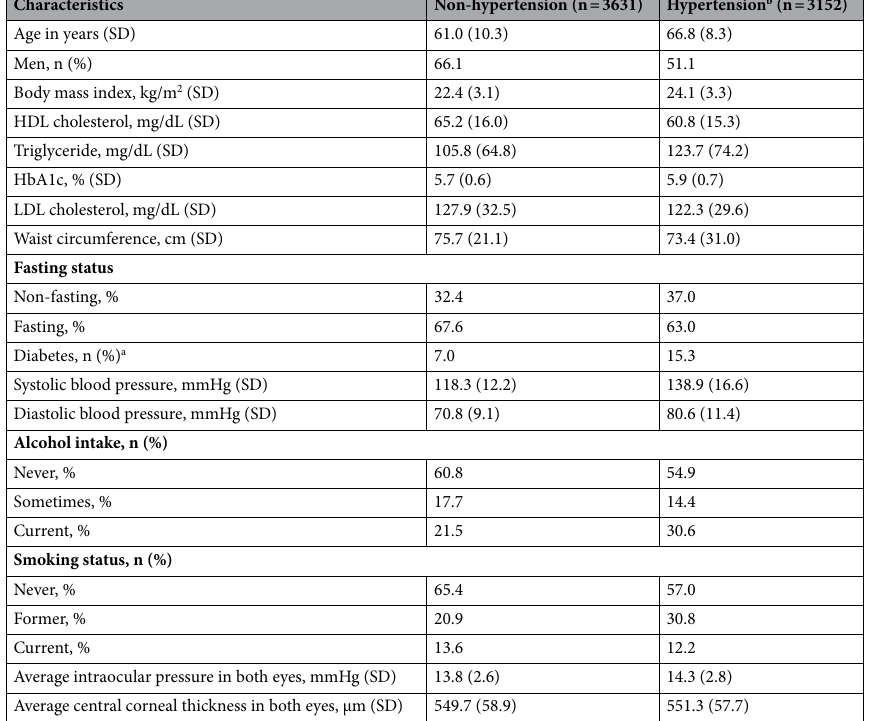
Table 1. Baseline demographic and clinical characteristics of included patients according to hypertensive status. Values are presented as the means (SDs) for continuous variables and percentages for categorical variables. HbA1c, haemoglobin A1c; HDL, high-density lipoprotein; LDL, low-density lipoprotein; SD, standard deviation. a Diabetes was defined as self-reported use of antidiabetic medication, self-reported history of diabetes, or HbA1c ≥ 6.5% b Hypertension was defined as use of any antihypertensive medication, systolic blood pressure ≥ 140 mmHg, and/or diastolic blood pressure ≥ 90